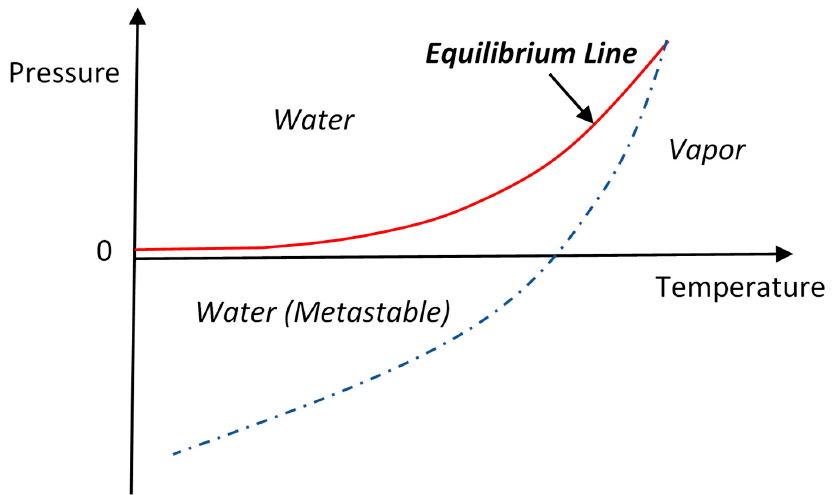
Figure 2. Schematic of phase diagram for water and the region of water in metastable state.